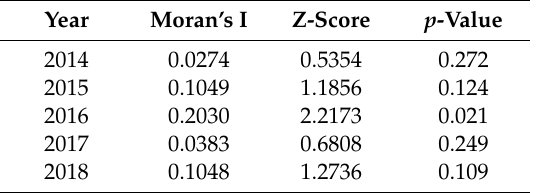
Table 2. Global spatial autocorrelation of varicella in Chongqing, 2014–2018.